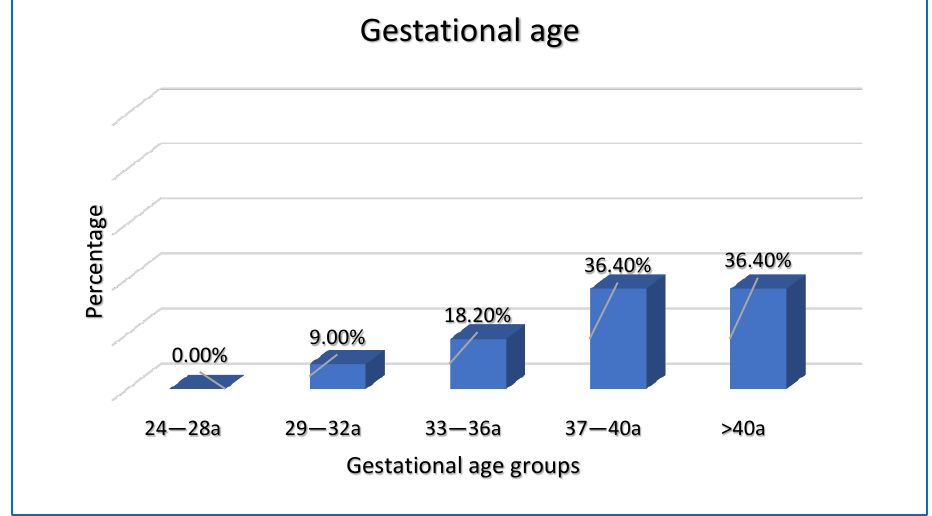
Figure 3. Gestational age and stillbirth.